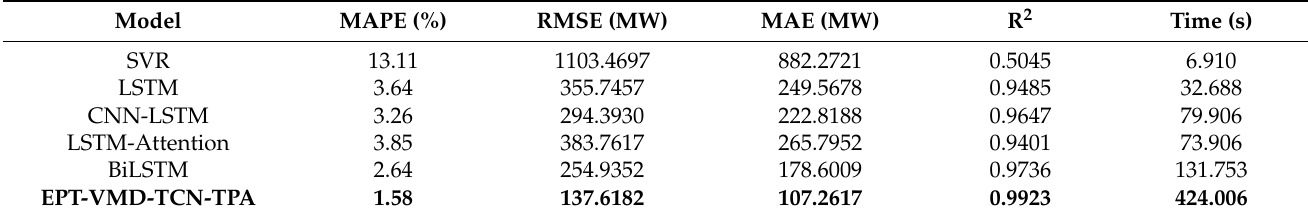
Table 13. Area 2 evaluation indicators for each